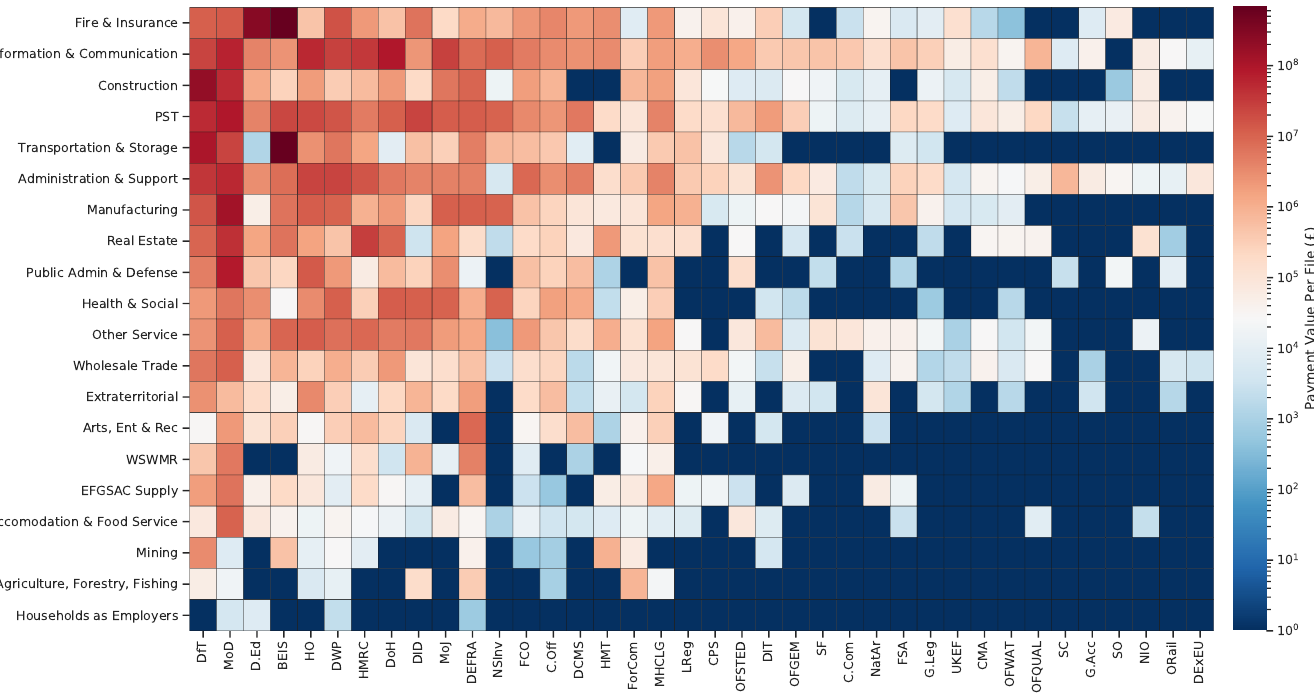
Figure 4: A decomposition across departments and aggregated SIC codes